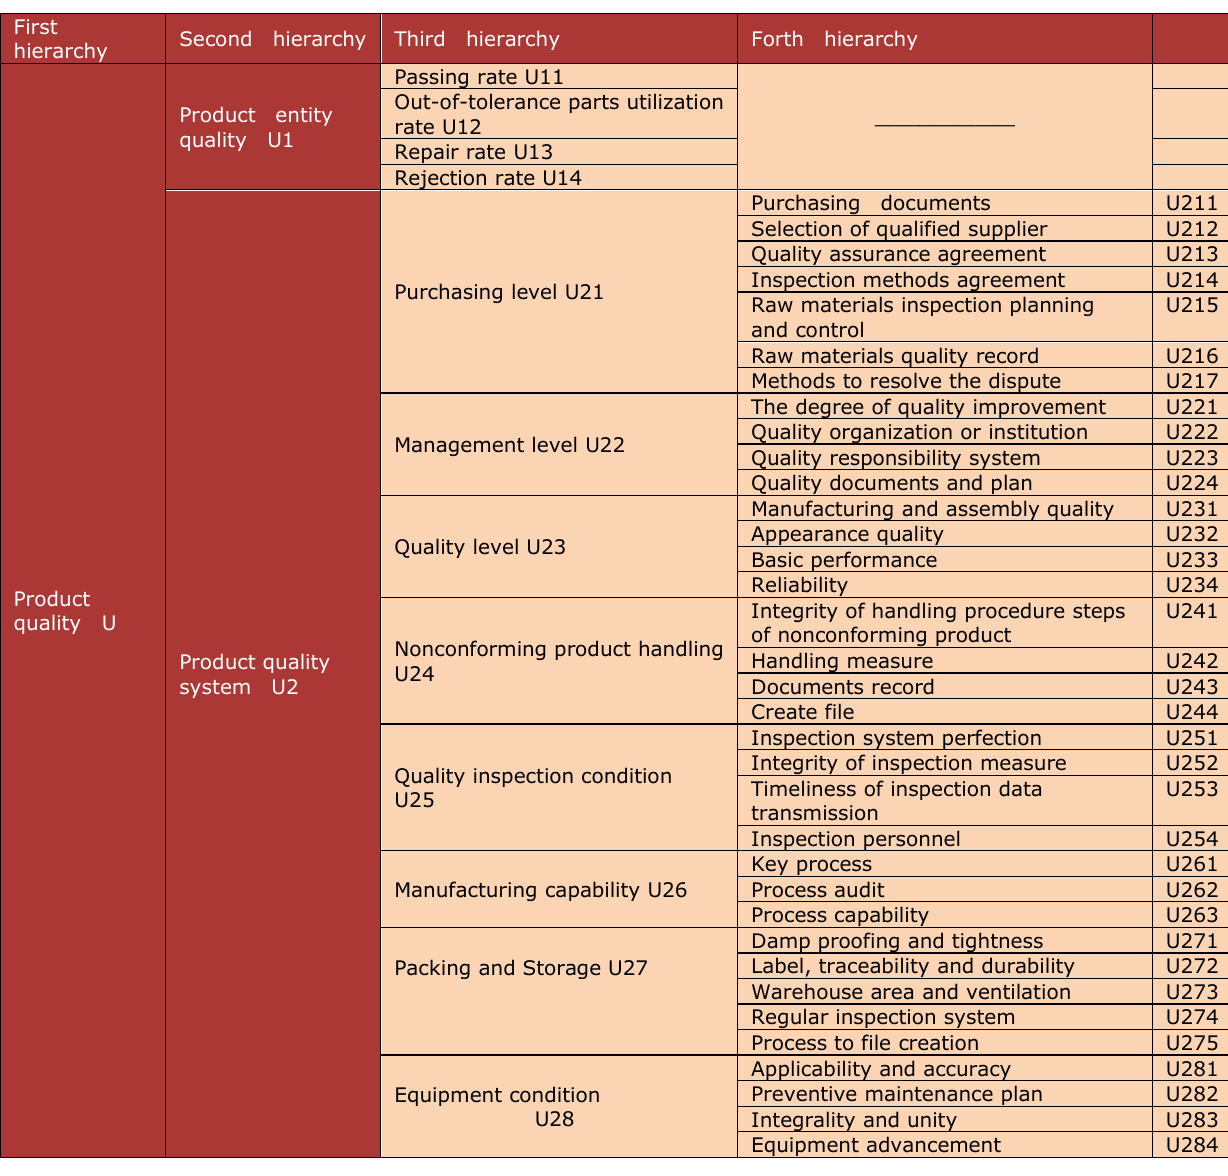
Table 2. Quality evaluation hierarchy